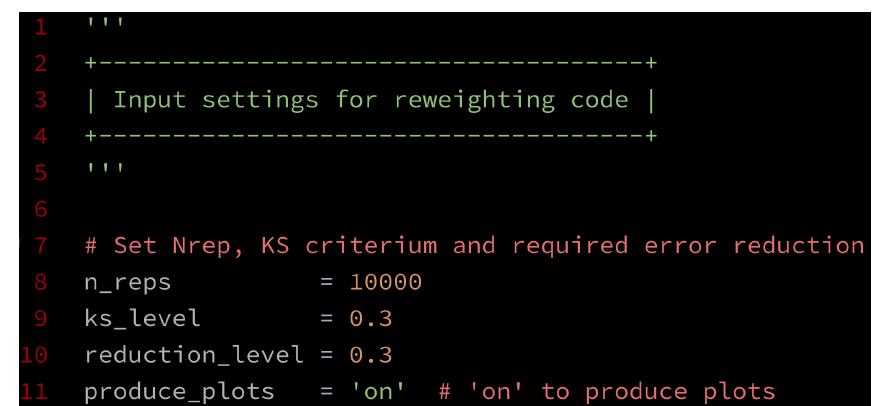
Figure A.1: A snapshot of the python script code_input.py . The input settings of the reweighting procedure can be defined